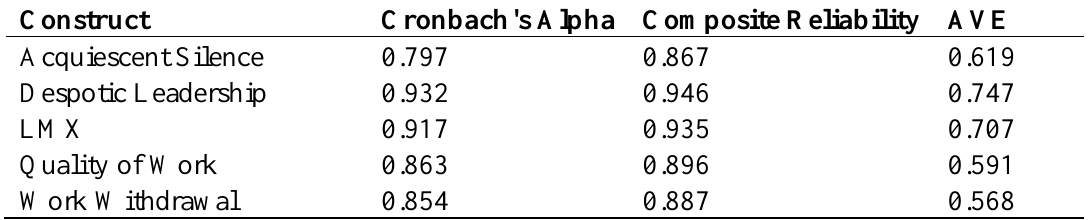
Table 2. Convergent Validity